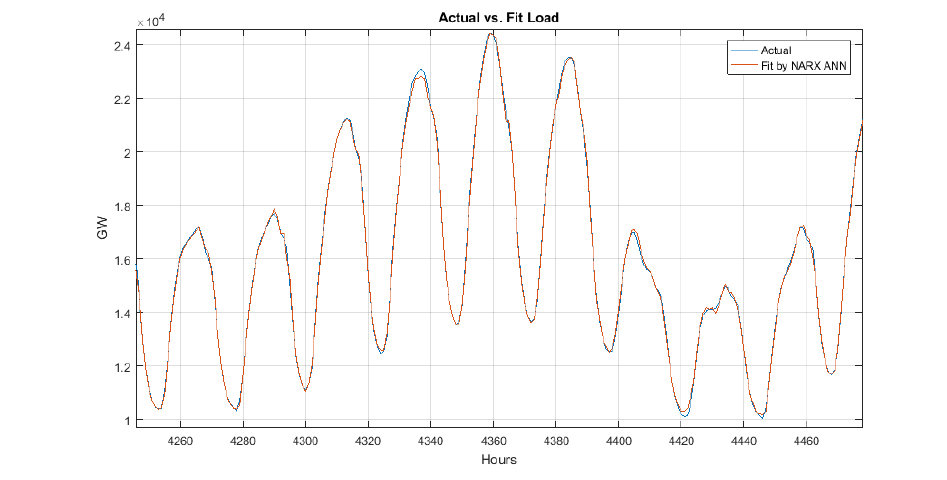
Figure 5. Open-loop fit of the NARX ANN model for one